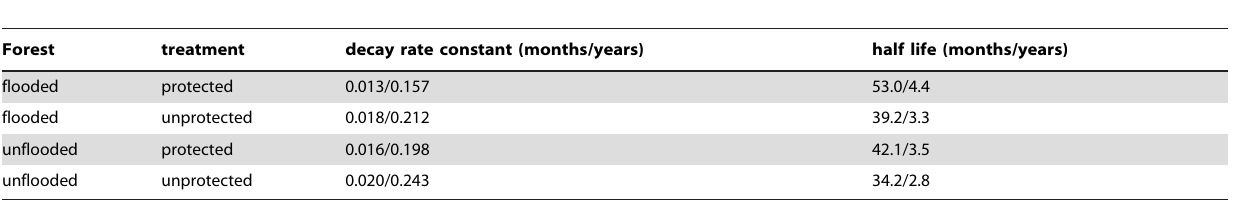
Table 2. Estimated decay rates and half-lives based on the single exponential decay model [3] and a mean initial specific gravity (based on samples collected when the trees were felled) of 0.45.